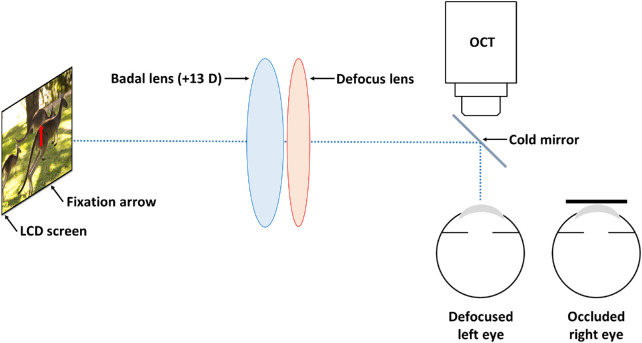
Schematic diagram of the Badal optometer and cold mirror mounted on the OCT instrument for simultaneous exposure of the left eye to defocus stimulus during the OCT imaging of the choroid. The optical axis of the Badal optometer was aligned with the center of the OCT objective lens. The left eye viewed a small arrow (∼0.75°) at the center of a movie displayed on an LCD screen. The fixation arrow was aligned with the optical center of the Badal lens and imaged at optical infinity through the Badal optometer. The defocus spherocylindrical trial lenses were positioned coaxially in front of the Badal lens, with their optical power vertex corrected to the left corneal plane.